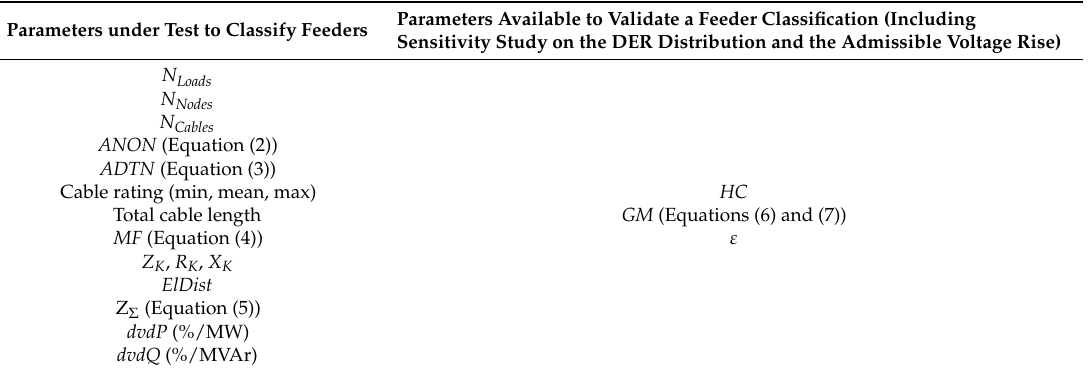
Table 1. Parameters under test and set of parameters for validation